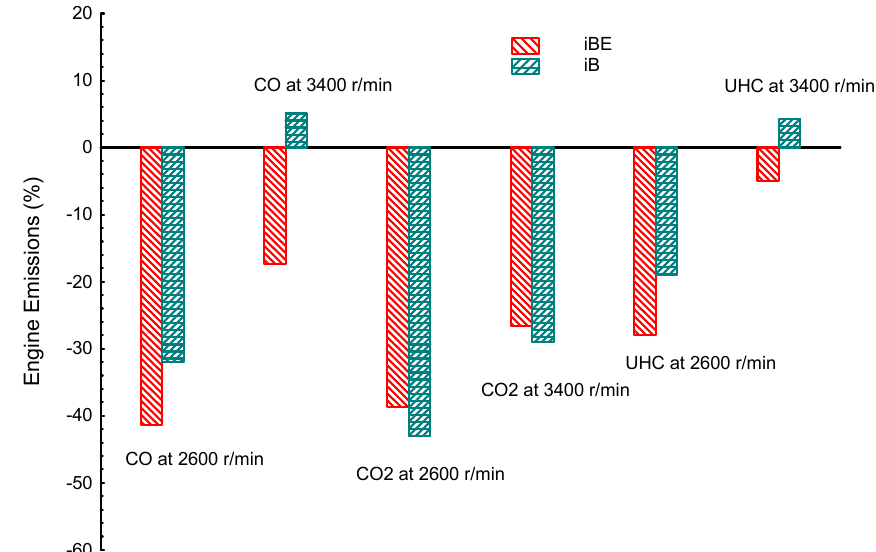
Figure 13. Comparison of CO, CO 2 and UHC emissions for i-butanol–bio-ethanol–gasoline blends (iBE), i-butanol–gasoline blends (iB) and neat gasoline (baseline) at two different speeds (2600 and 3400 r/min).